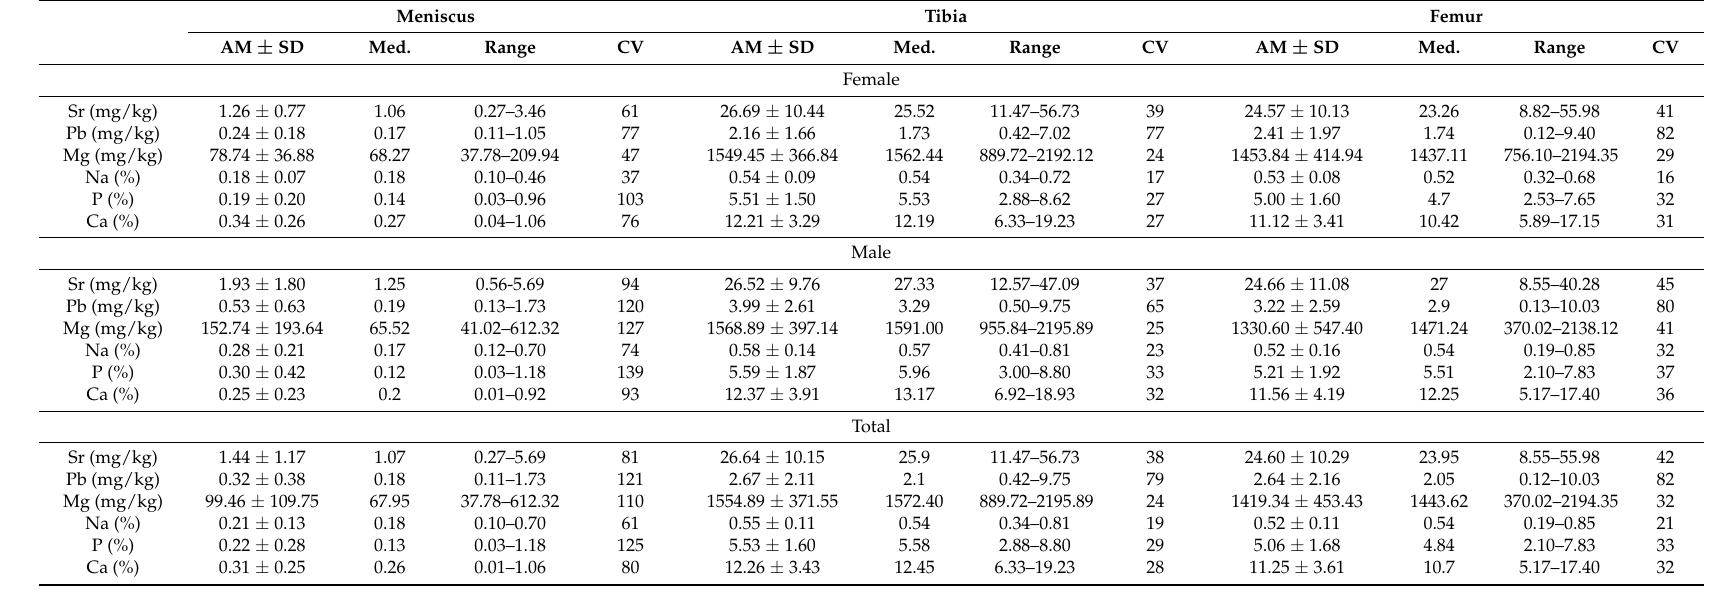
Table 2. Statistical characteristics for concentration of strontium, lead, magnesium, sodium, phosphorus and calcium in tissues of the knee joint (AM—arithmetic mean; SD—standard deviation; Med—median; CV—coefficient variability; M–W—Mann–Whitney U test;